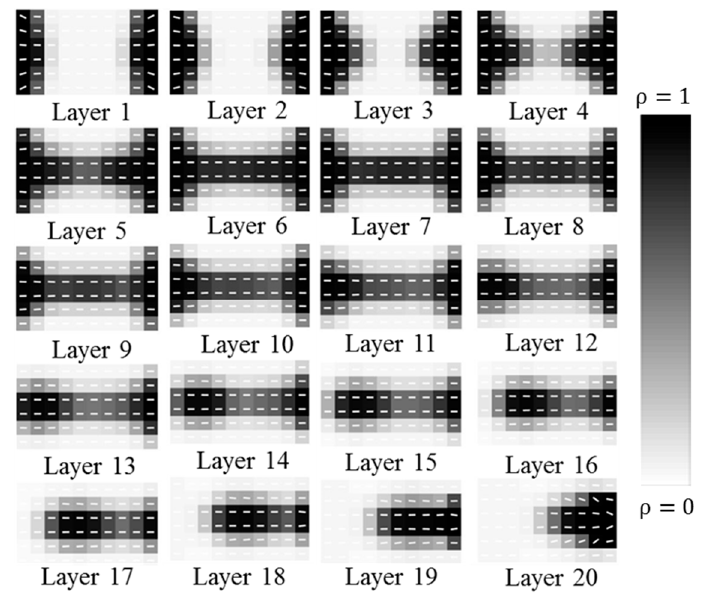
Figure 15. Topology result for Case 3 (front view). Elements with 𝜌 (cid:3032) ≤ 0.5 are not shown.